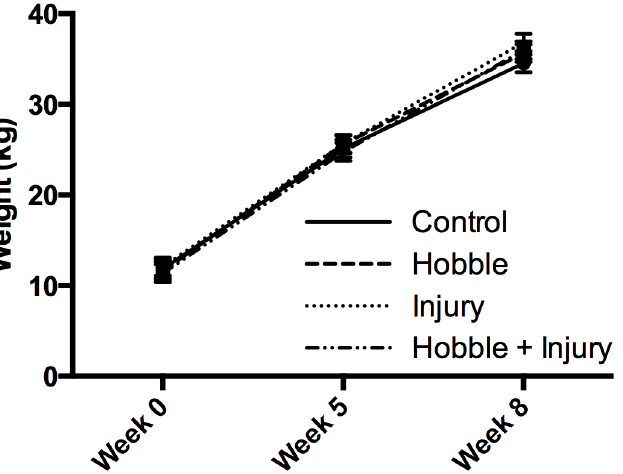
Fig 4. Pig growth over the course of the experiment. There were no significant weight differences among groups at 0, 5, and 8